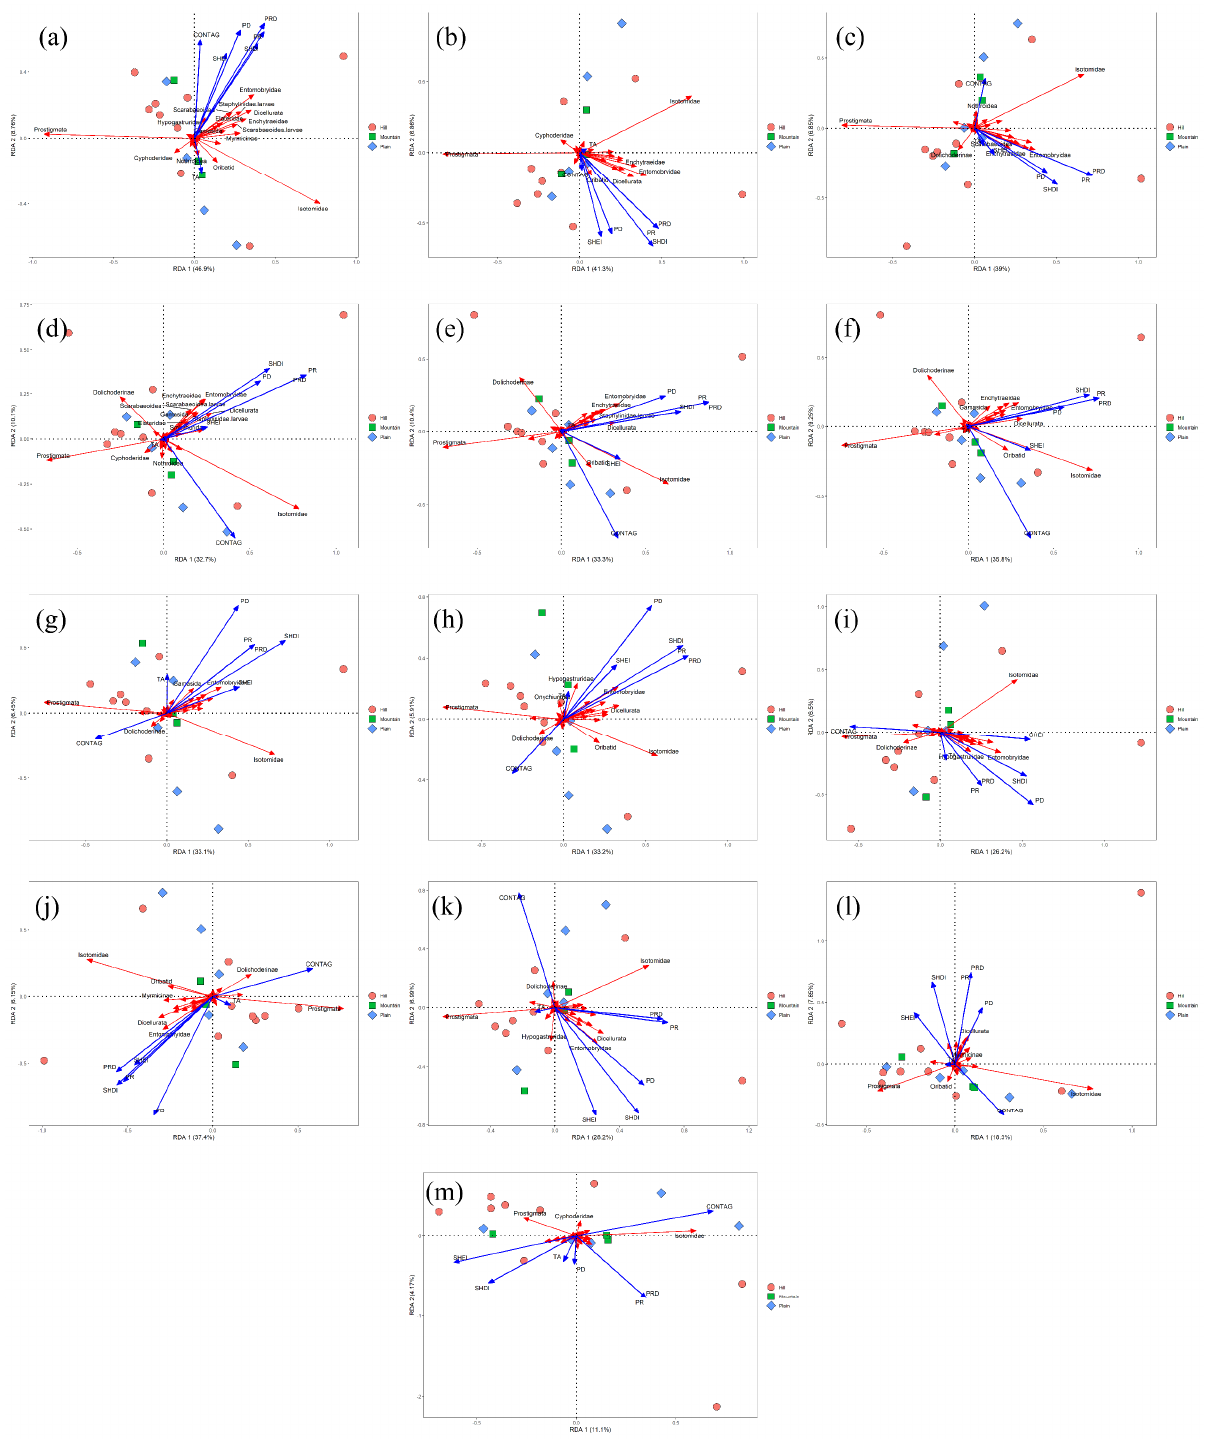
Figure A2. Ordination diagram for the RDA analysis for soil fauna distribution and landscape indices in farmland. ( a ) 25 m buffer radius. ( b ) 50 m buffer radius. ( c ) 75 m buffer radius. ( d ) 100 m buffer radius. ( e ) 125 m buffer radius. ( f ) 150 m buffer radius. ( g ) 175 m buffer radius. ( h ) 200 m buffer radius. ( i ) 225 m buffer radius. ( j ) 250 m buffer radius. ( k ) 500 m buffer radius. ( l ) 750 m buffer radius. ( m ) 1000 m buffer radius.